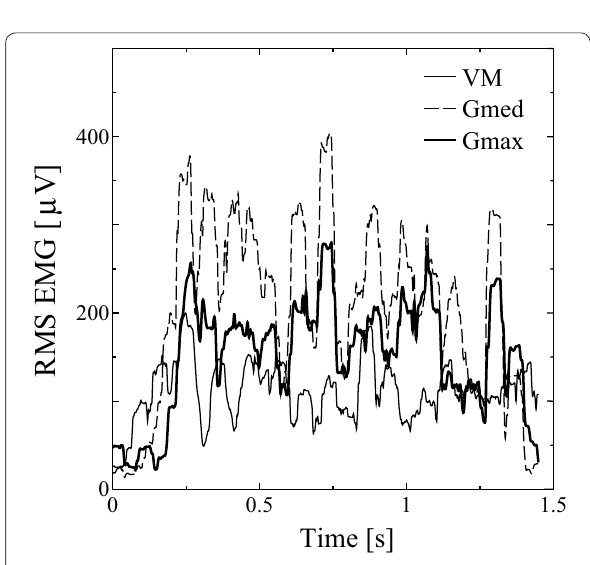
Fig. 20 RMS EMG during isotonic exercise. The target force was 120 N